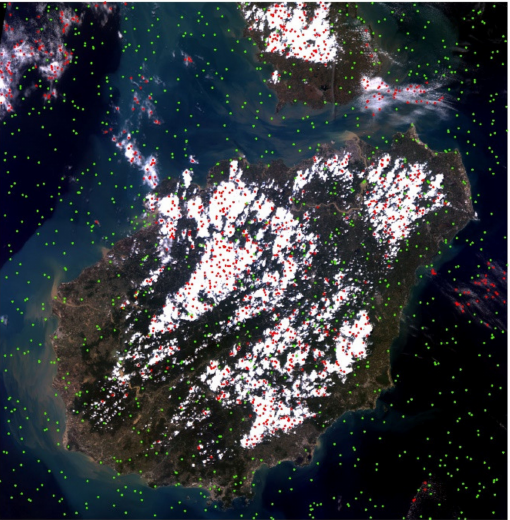
Figure 5. The 2000 random points generated for the Hainan study area that were used for the accuracy assessment. Red points indicate clouds and green points indicate